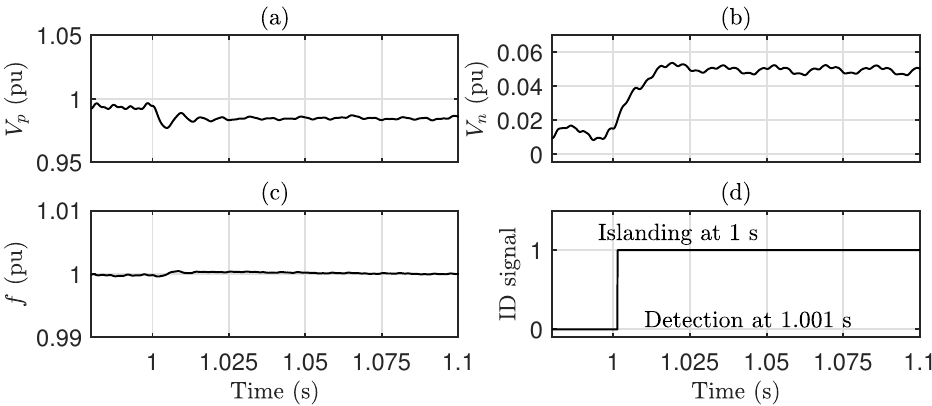
Figure 10. L -type filter case: Performance under weak grid condition with SCR = 1.8: ( a , b ) estimated magnitudes of positive- and negative-sequence PCC voltage, respectively; ( c ) estimated frequency; and ( d ) ID signal.